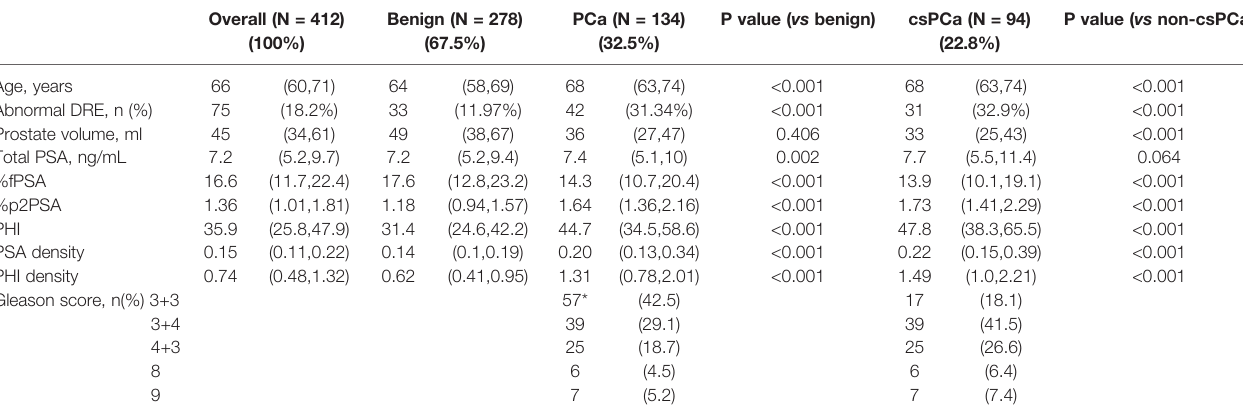
TABLE 1 | Characteristics of the study